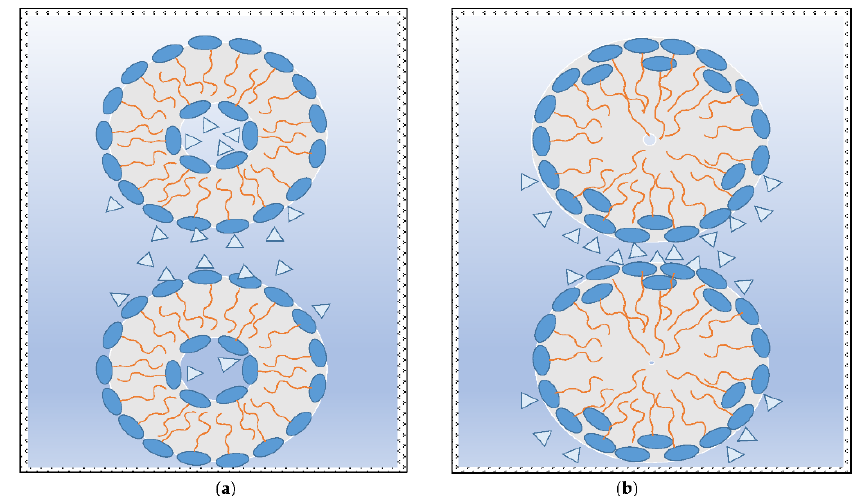
Figure 4. Schematic representation a formation of micellar, rod-like, or disc-like bilayers by prevailing weak/strong hydro-attraction. ( a ) Prevailing weak hydro-attraction; ( b ) Prevailing strong hydro- attraction. The symbols “ ∆ ” denominate water molecule O < H H .